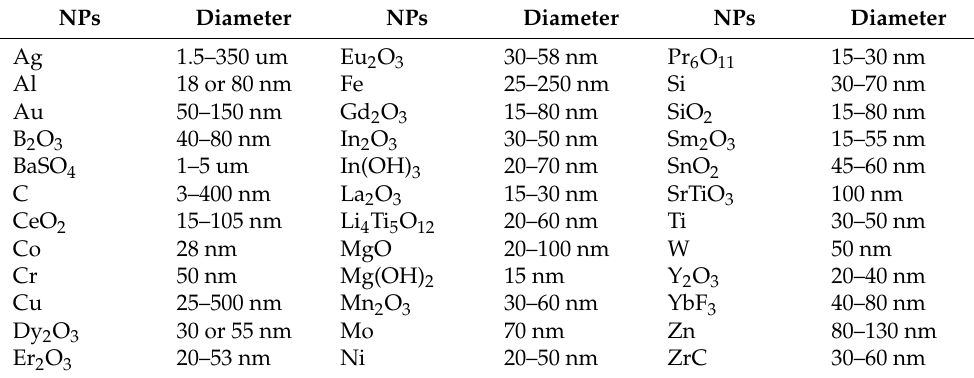
Table 1. Nanoparticles in biomedical applications